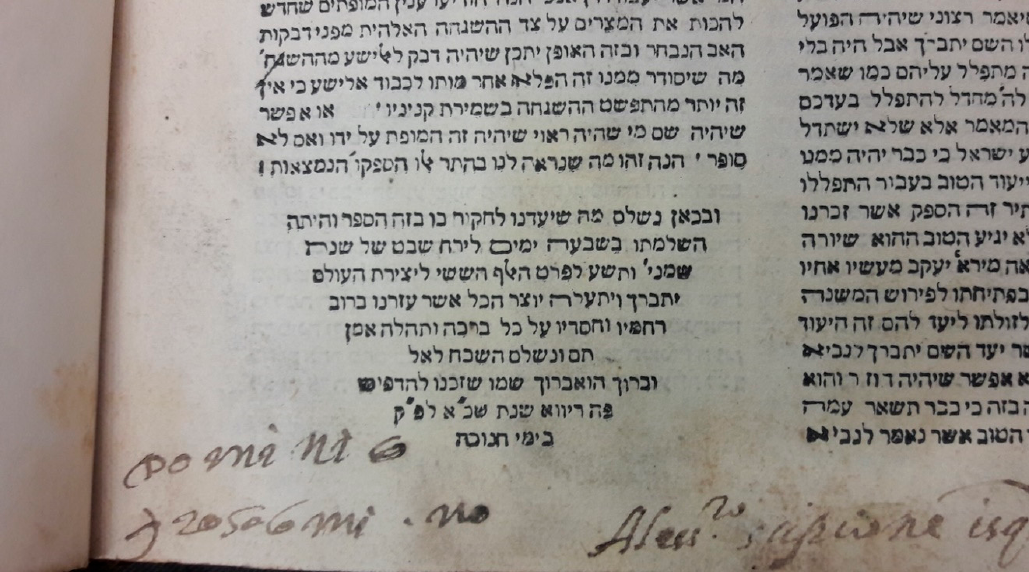
Figure 36. Detail of Milhamoth ha-Shem, War of the Lord, Marsh’s Library B.3.3.2. Photo courtesy of Dr Javier del Barco.